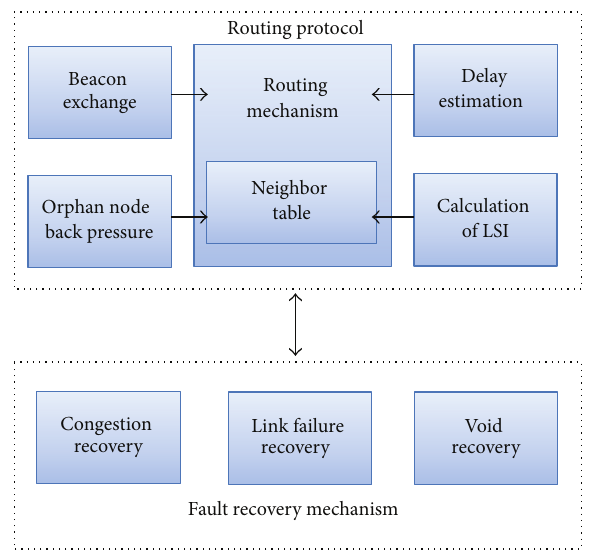
Figure 5: Components of scheme proposed in [11].